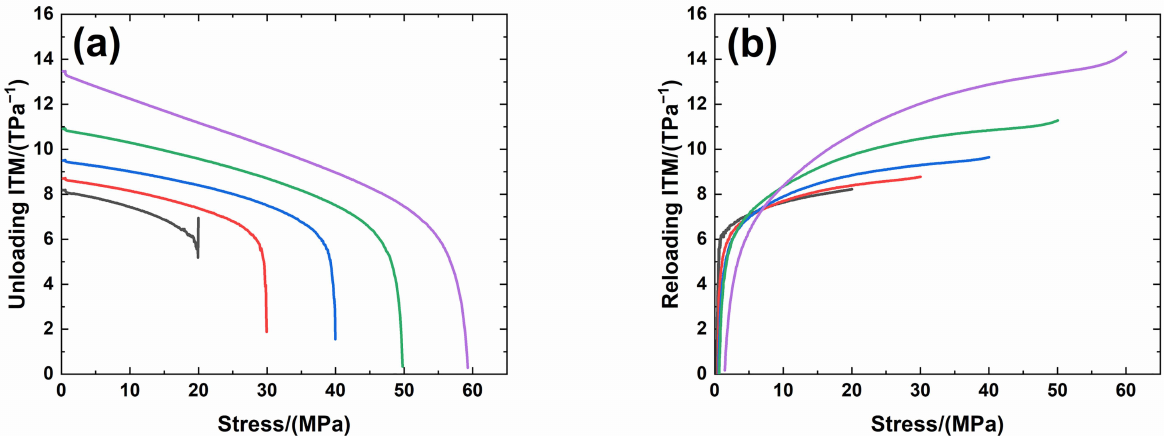
Figure 11. ( a ) Unloading ITM; and ( b ) reloading ITM of Type 4 3D needle-punched C/SiC